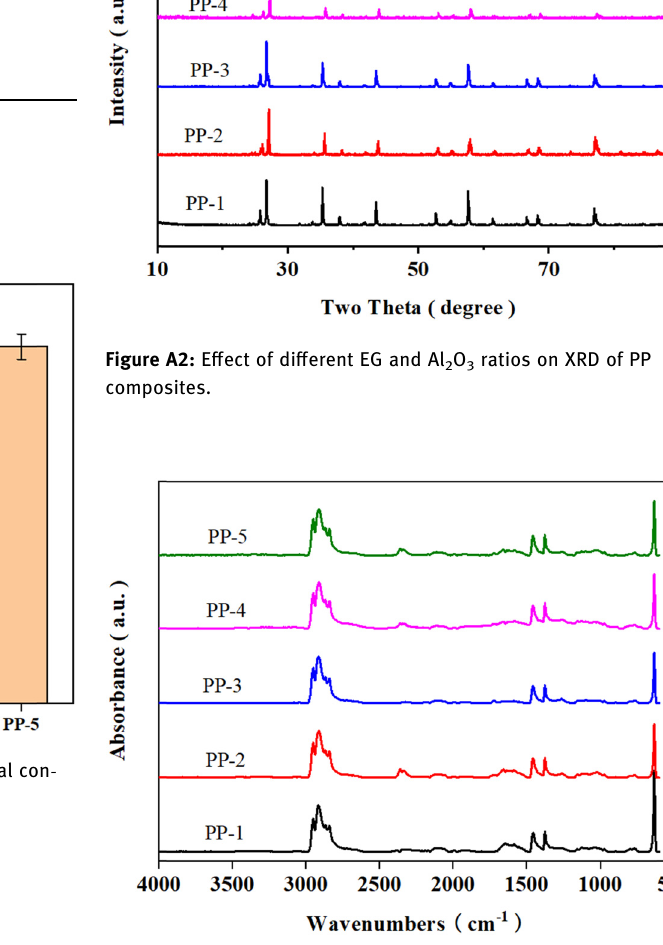
Figure A3: E ff ect of di ff erent EG and Al 2 O 3 ratios on FTIR of PP